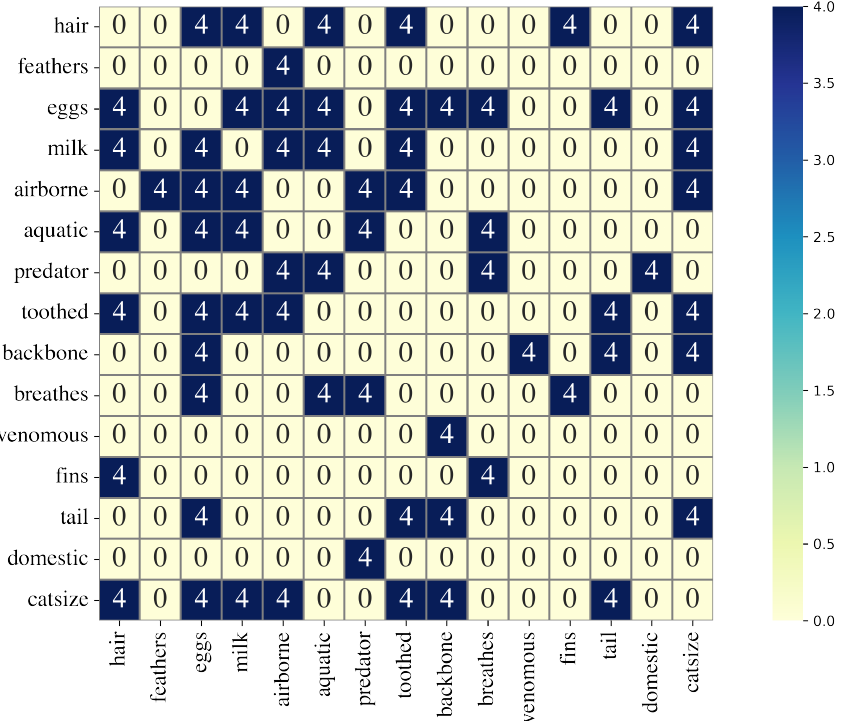
Figure 4. Results using only some variables of Zoo data